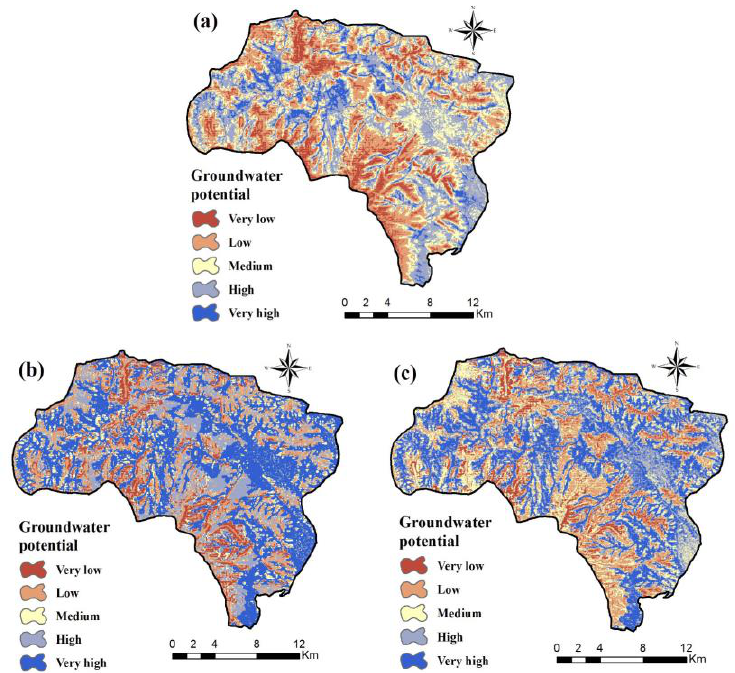
Figure 8. Groundwater potential maps produced by sampling dataset 3 and ( a ) GARP, ( b ) QUEST, and ( c ) RF.